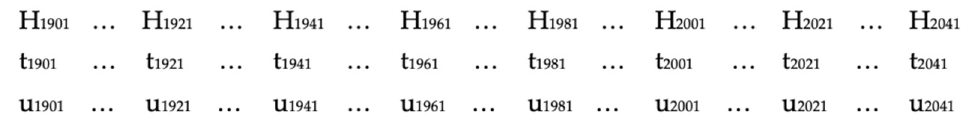
Figure 1. A hypertemporal universe with no time travel.